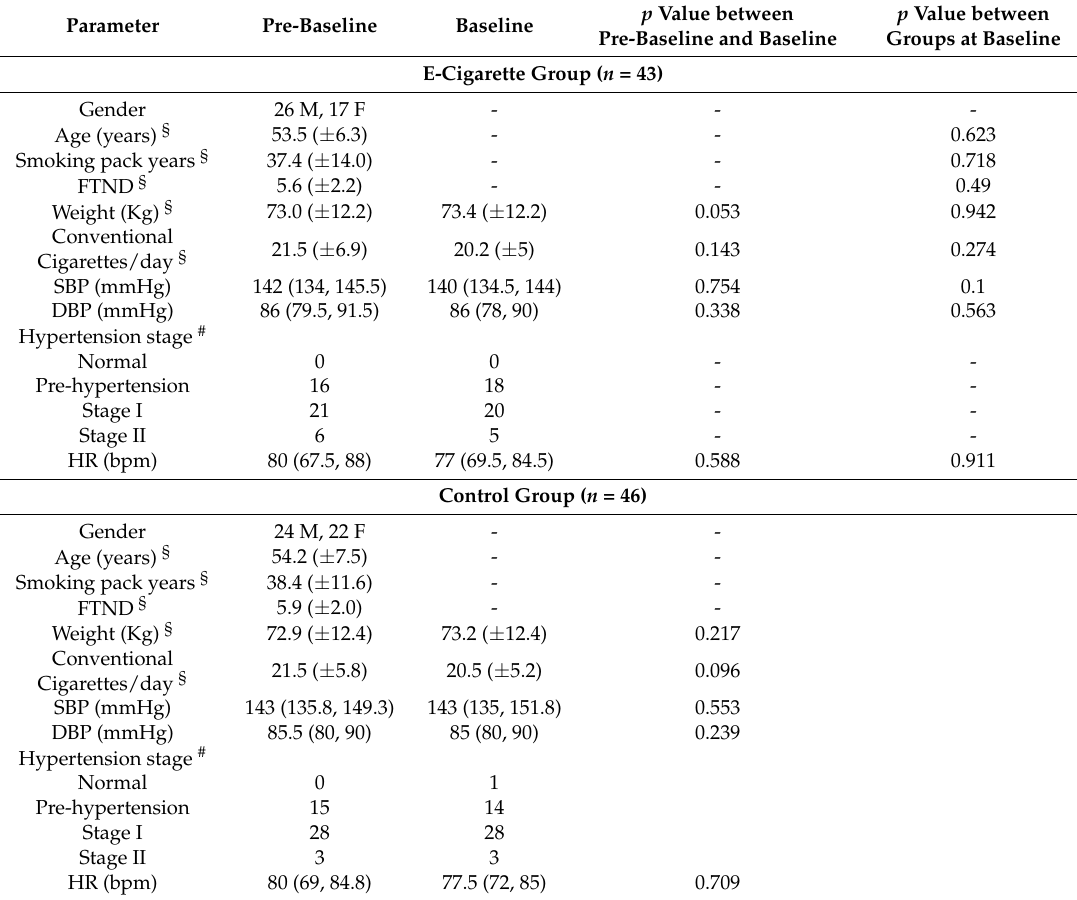
Baseline measurements in all subjects prior to initiation of electronic cigarette and control